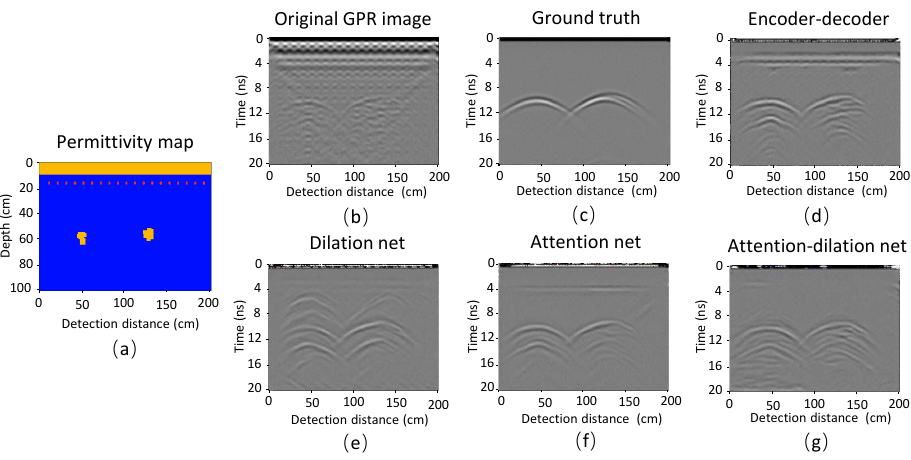
Figure 5. Processing results of RCE-GAN and its variants when the spacing between rebar is 10 cm. ( a ) permittivity map of the FDTD model; ( b ) original GPR image; ( c ) ground truth GPR image; ( d – g ) are the processing results of encoder–decoder, dilation net, attention net, and attention-dilation net (RCE-GAN),